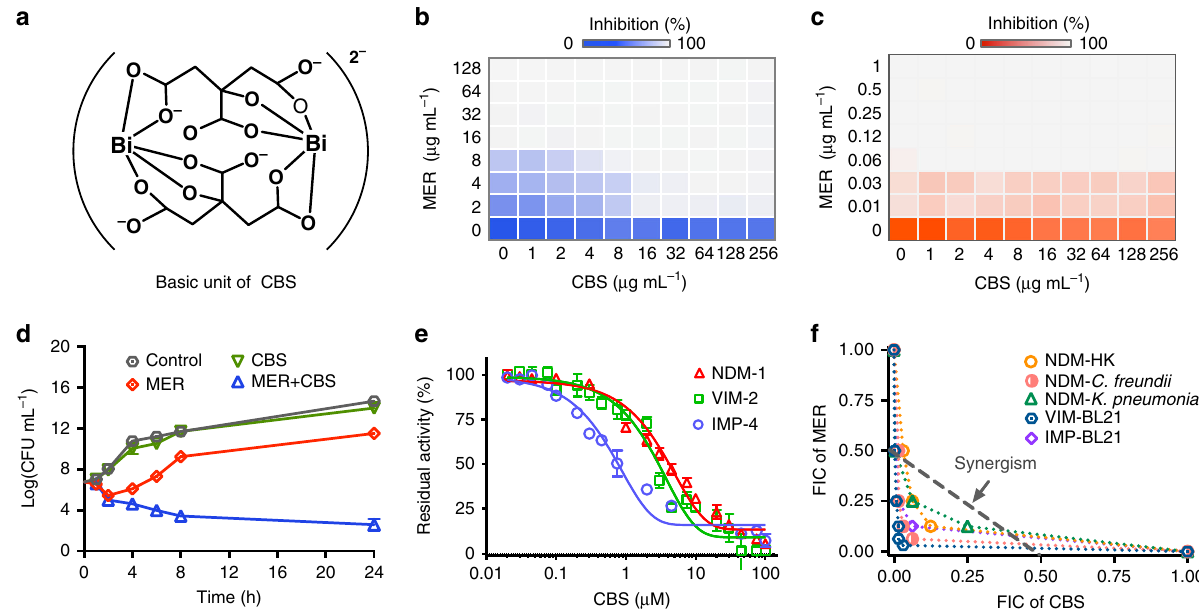
Fig. 1 CBS inhibits the in vitro activity of MBLs. a Basic dimeric unit of CBS. b , c Representative heat plots of microdilution checkerboard assay for the combination of MER and CBS against NDM-HK ( b ) and NDM-HK PCV ( c ). d Time kill curves for MER and CBS monotherapy and combination therapy against NDM-HK during 24 h incubation. The concentrations of MER and CBS are 24 μ g mL -1 and 64 μ g mL -1 , respectively. e Inhibition pro fi les for MBLs by CBS with IC 50 values of 2.81, 3.54, and 0.70 µ M for NDM-1, VIM-2, and IMP-4, respectively. Mean value of three replicates are shown and error bars indicate the standard deviation (SD). f Isobolograms of the combination of MER and CBS against different MBL-positive bacterial strains. The gray line indicates ideal isobole, where drugs act additively and independently. Data overlapping with this line indicate additive effects. Data points below this line indicate synergism